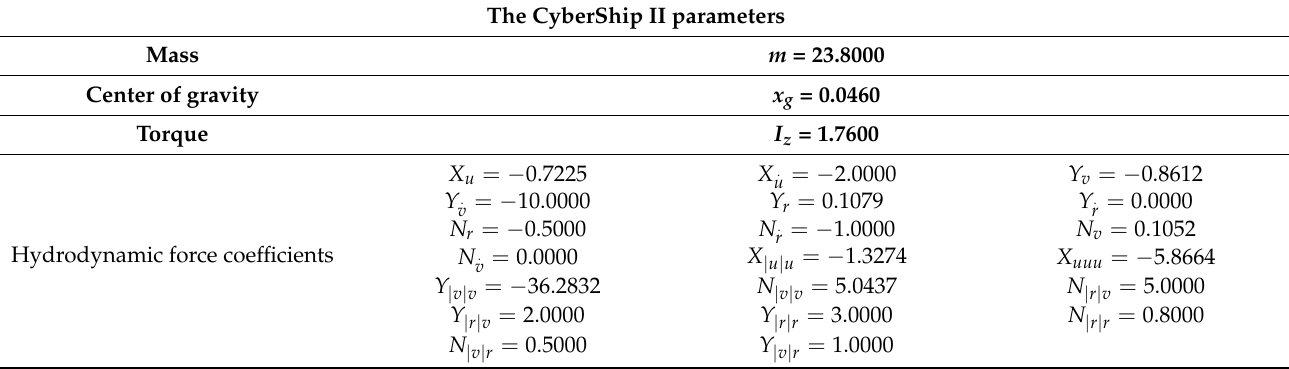
Table 1. The CyberShip II